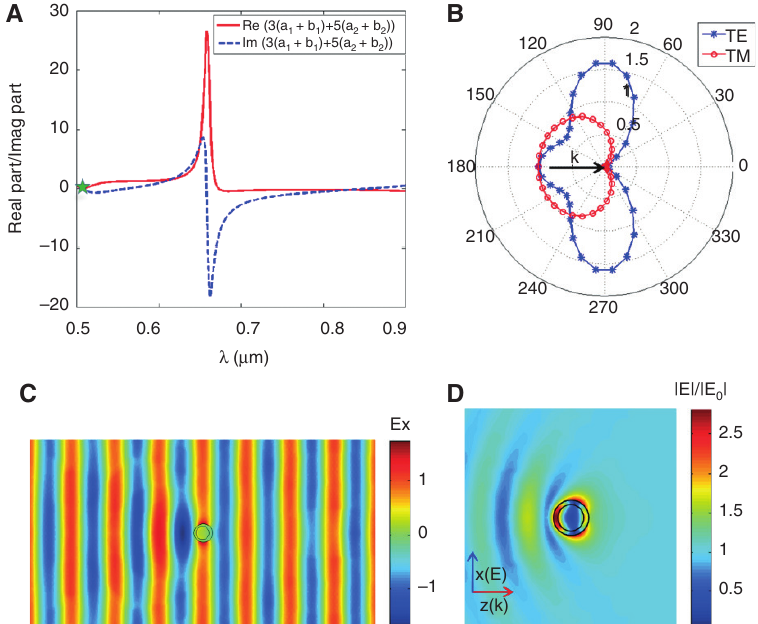
+ b + b ) + 5( a ) = 0 for the used core-shell spherical nanoparticle as a function of 1 1 2 2